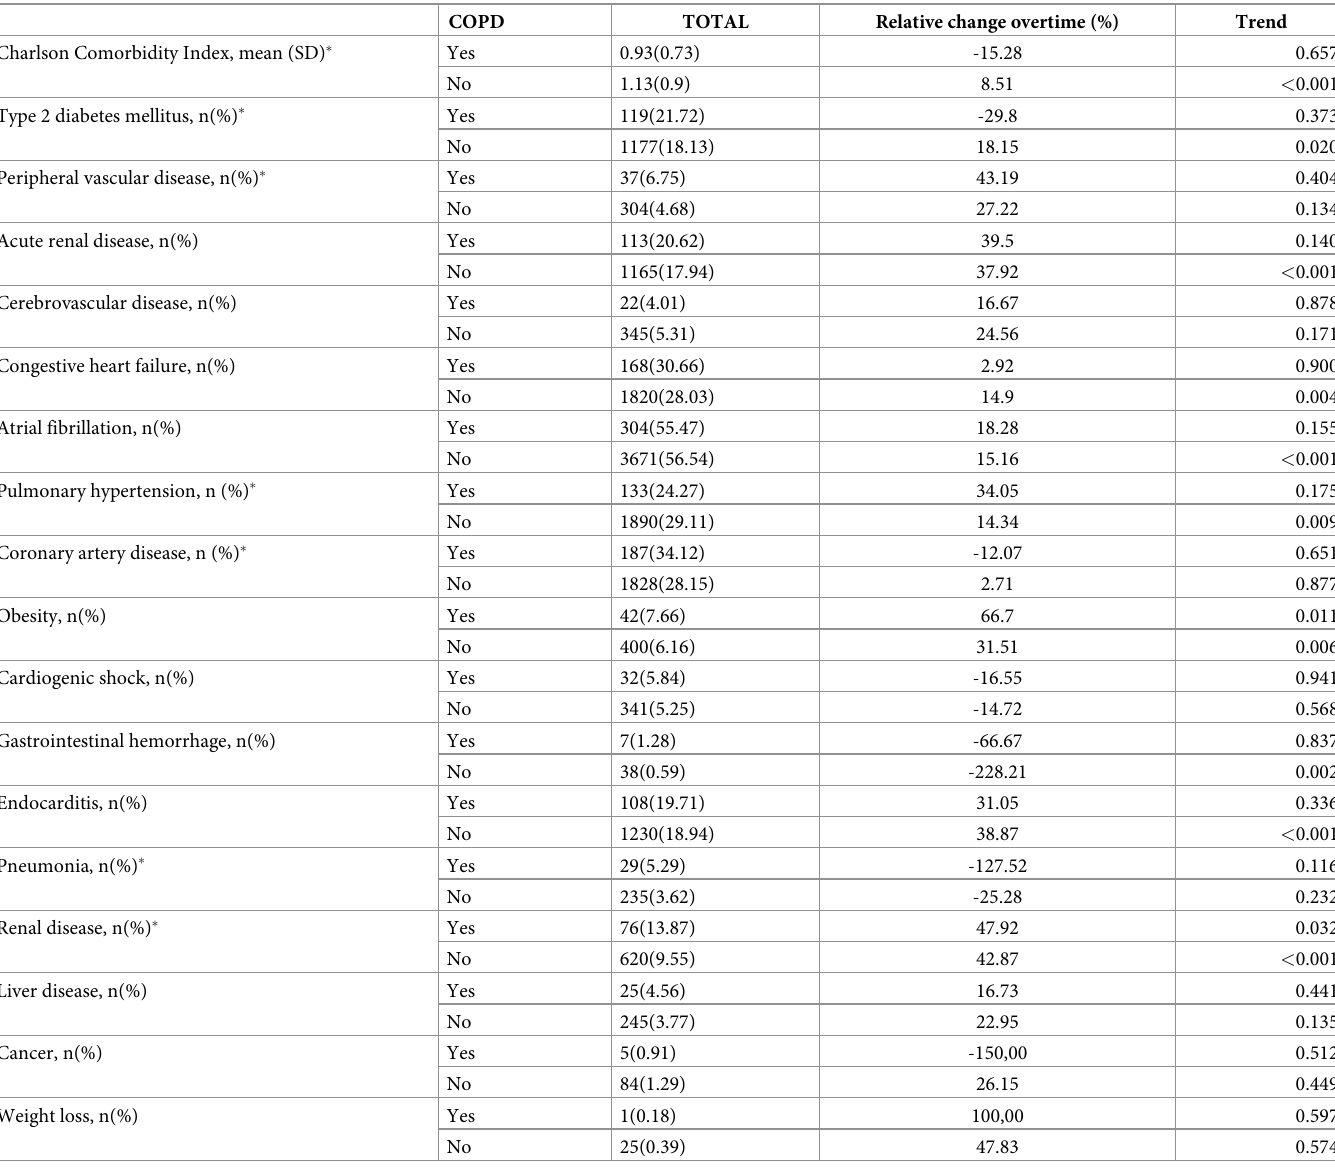
Table 5. Comorbidity of patients hospitalized that underwent a bioprosthetic mitral valve replacement in Spain from 2001 to 2015 according to COPD status. COPD TOTAL Relative change overtime (%) Trend Charlson Comorbidity Index, mean (SD)